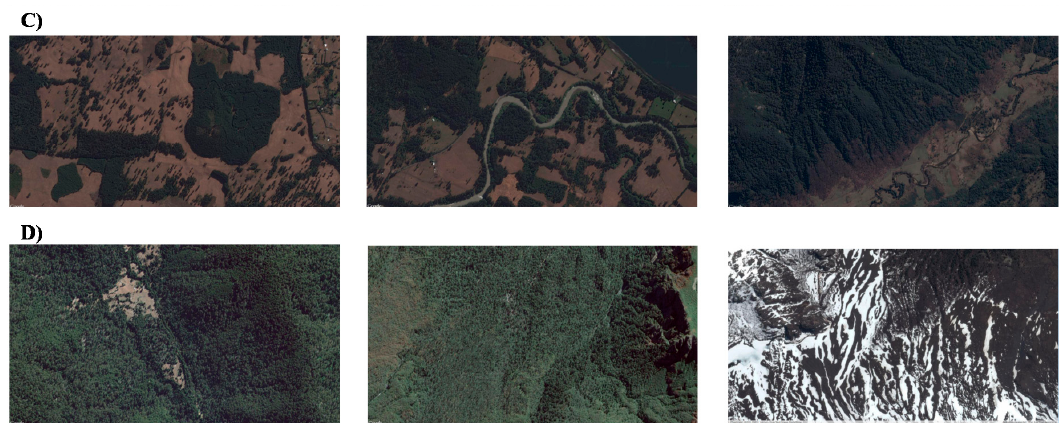
Figure A2. Google Earth aerial images used: ( A ) Freire, ( B ) Lumaco, ( C ) Pucón, ( D ) Curarrehue. (Scale of 1:10,000).